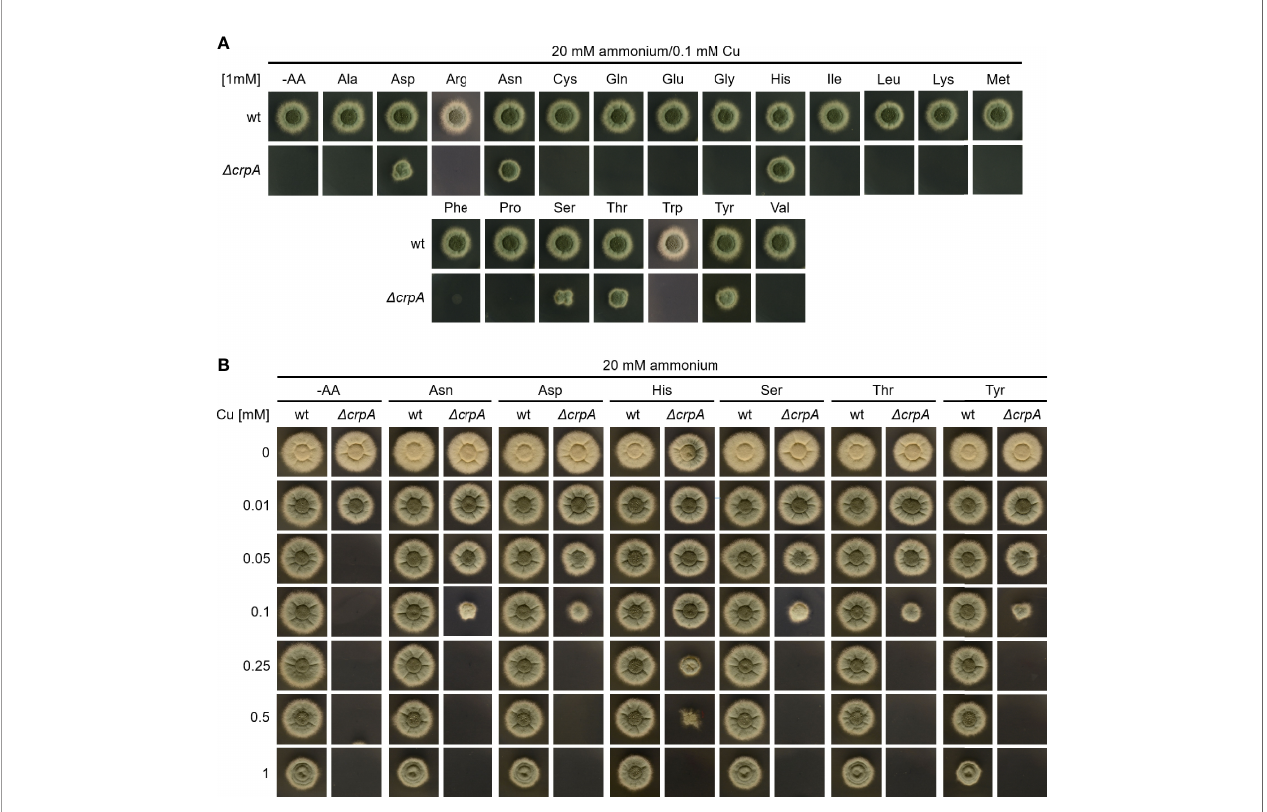
FIGURE 2 | Supplementation with Asn, Asp, Ser, Thr, Tyr, and particularly His protects A. fumigatus D crpA against Cu toxicity to a higher degree compared to other AAs. A. fumigatus wt and D crpA conidia were point-inoculated on solid AMM containing 20 mM ammonium as nitrogen source. (A) The growth medium contained 0.1 mM Cu and was supplemented with 1 mM of the different AAs indicated (arginine, Arg; cysteine, Cys; glutamate, Glu; glycine, Gly; isoleucine, Ile; leucine, Leu; lysine, Lys; methionine, Met; phenylalanine, Phe; proline, Pro; tryptophane, Trp; valine, Val); -AA was without AA supplementation. (B) The growth medium contained 1 mM of the indicated AA and the different Cu concentrations